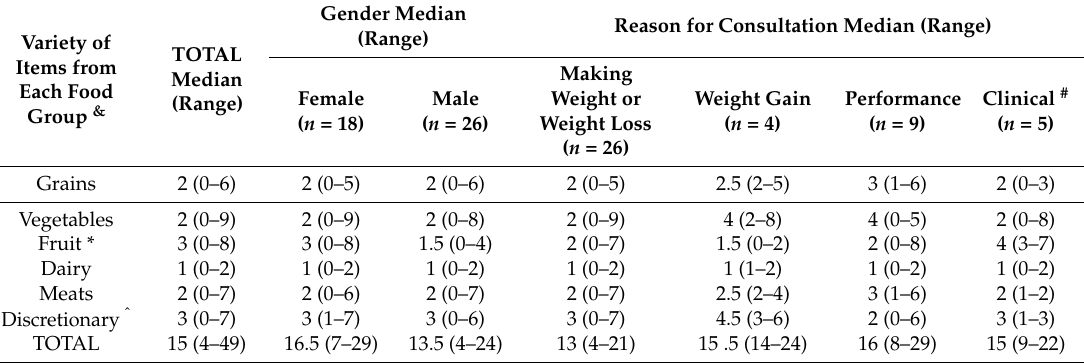
Table 4. Variety of items consumed from each food group and dietitians rating of diet and nutrition knowledge based on gender and reason for requesting